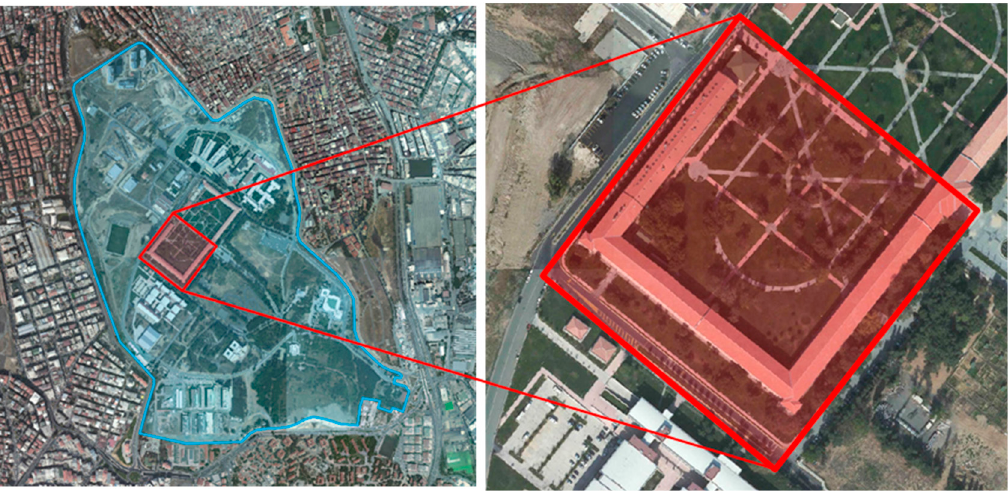
Figure 1. Davutpasa Campus of Yildiz Technical University ( left ) and the urban study area ( right ).